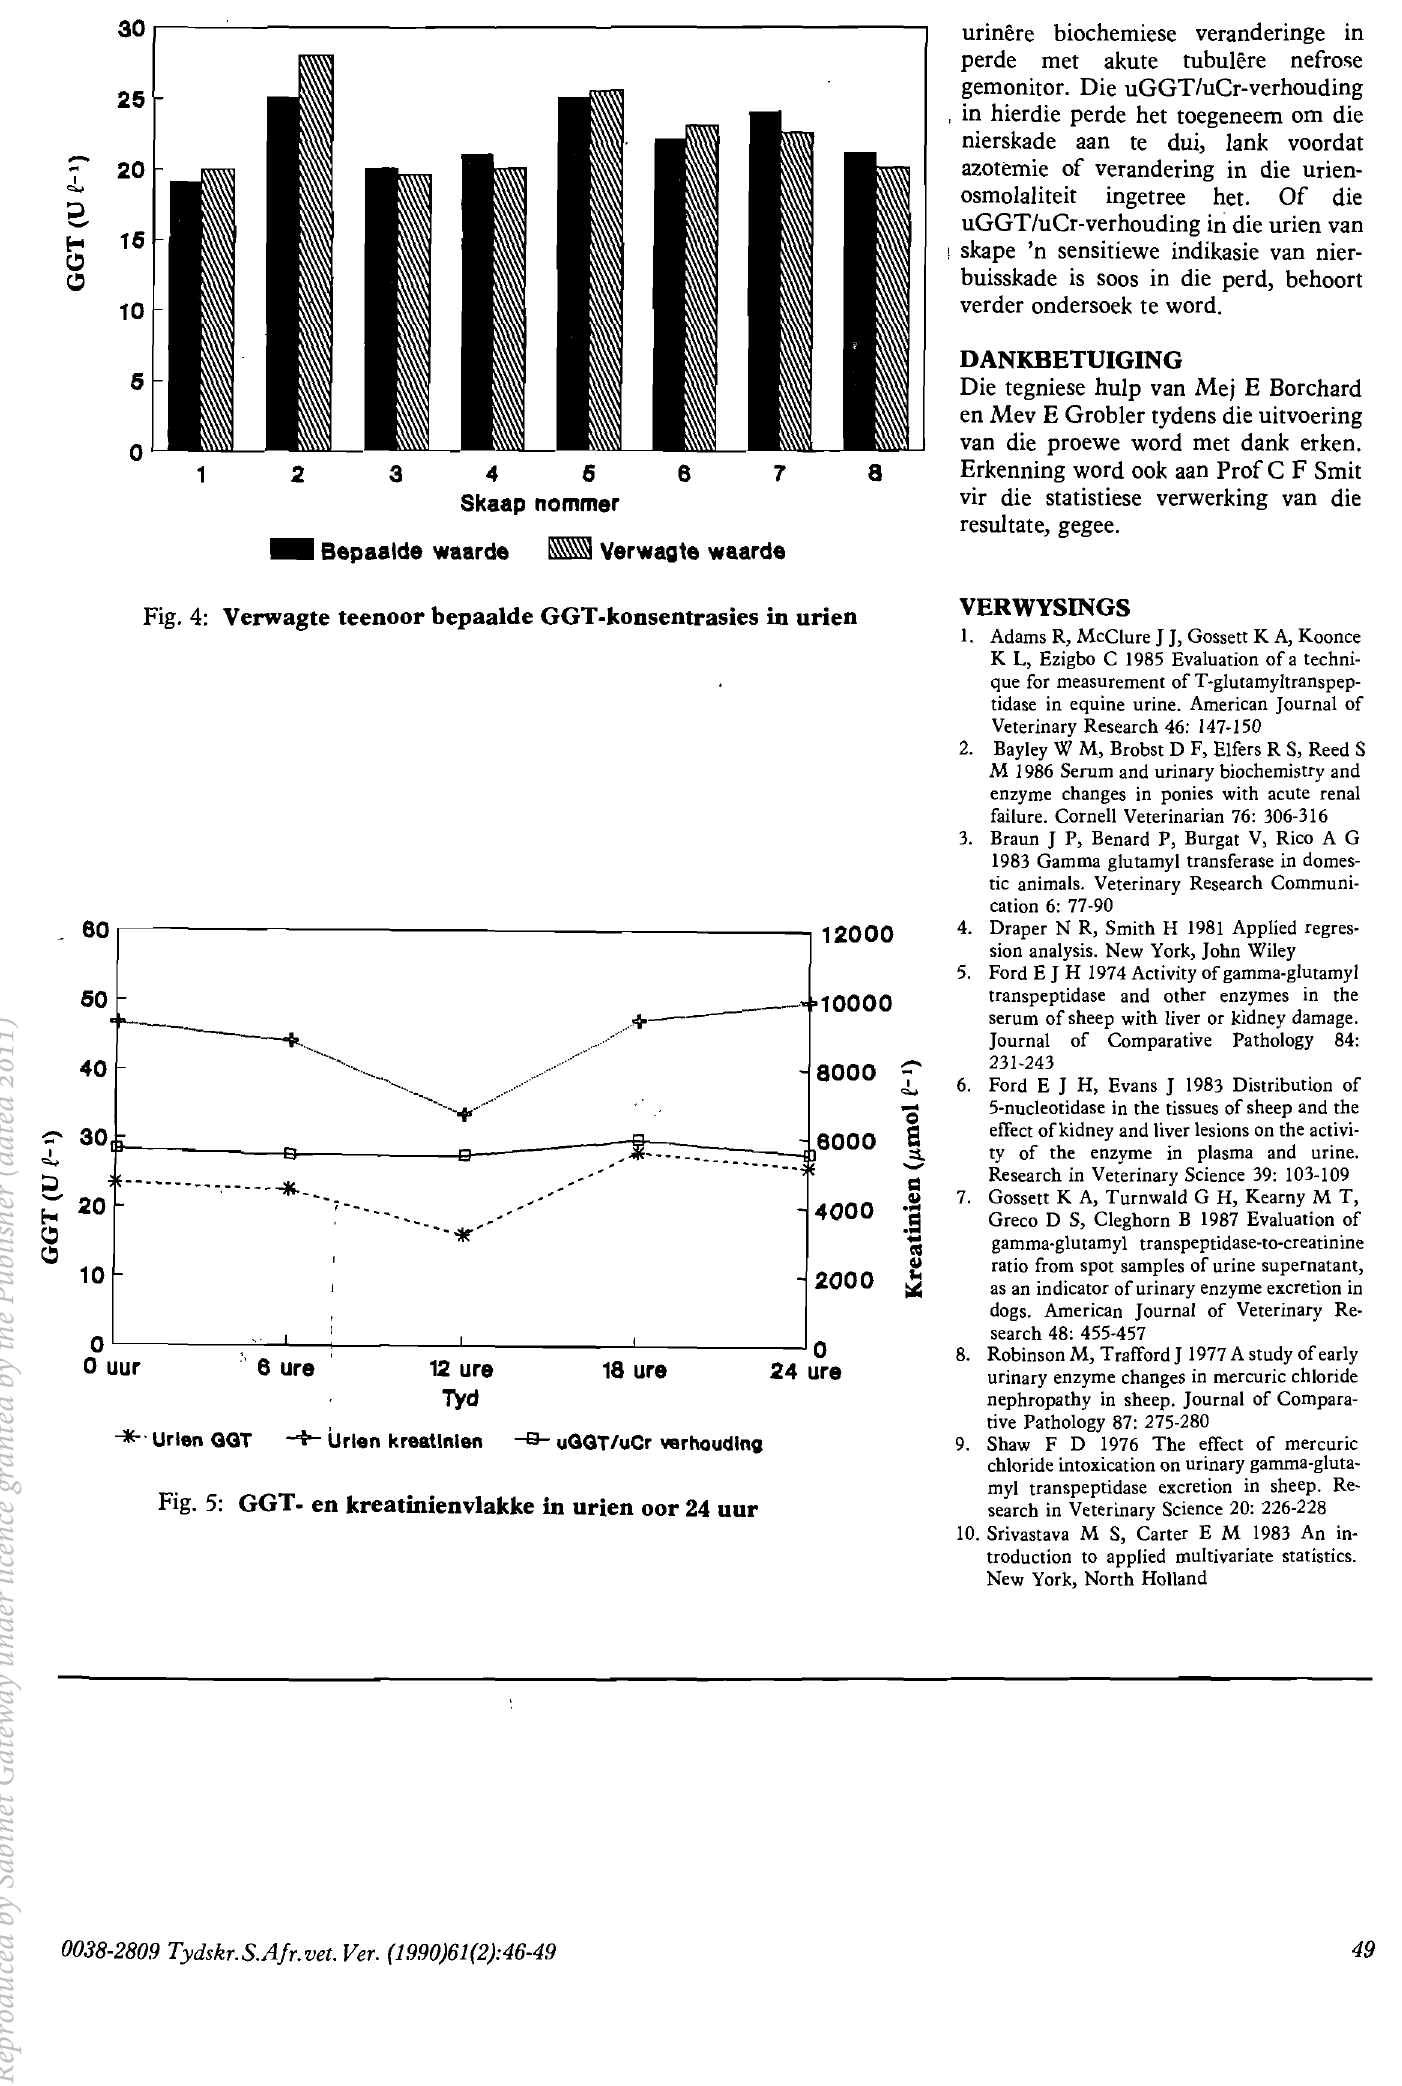
Fig. 5: GGT- en kreatinienvlakke in urien oor 24 uur